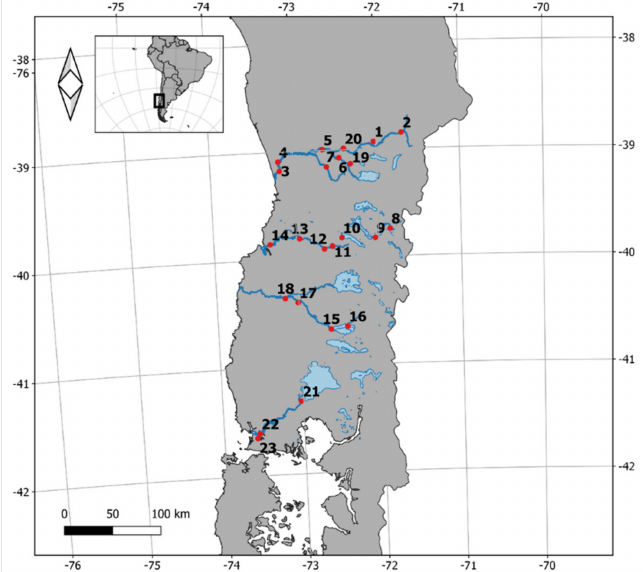
Figure 1. Geographic location of study sites within four river basins. 1, Cunco; 2, Melipeuco; 3, Nueva Tolt é n; 4, Hualp í n; 5, Pitrufqu é n; 6, Coipu é ; 7, Donguil; 8, Liquiñe; 9, Choshuenco and Neltume lakes; 10, Riñihue; 11, Las Huellas; 12, Santa Rita; 13, Antilhue; 14, Valdivia; 15, Pilmaiqu é n; 16, Mantilhue; 17, San Pablo; 18, Trumao; 19, Catrico; 20, Radal; 21, Puerto Varas; 22, Maull í n; and 23, Gonz á lez